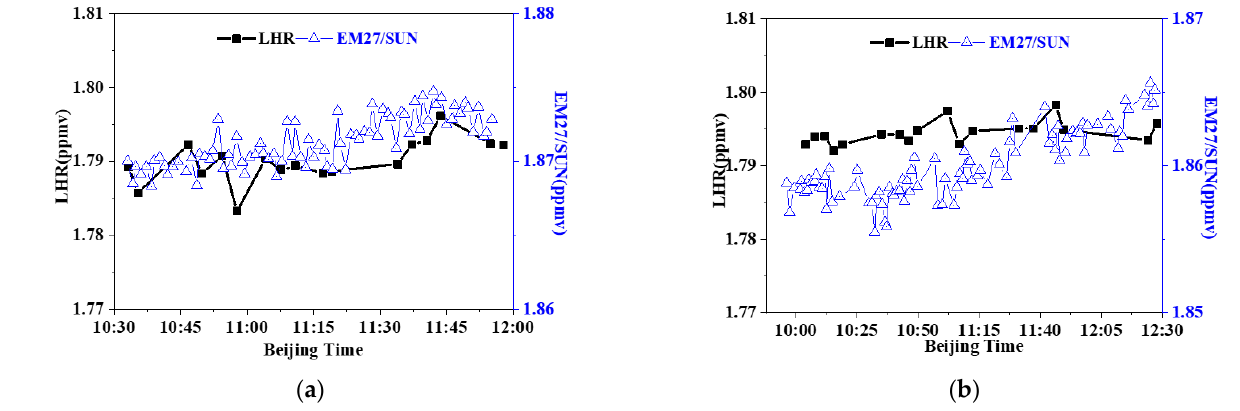
Figure 12. The methane column density of EM27/SUN and LHR on ( a ) 20 and ( b ) 21 July. The average values of methane measured by LHR were 1.79 ppmv on 20th and 1.794 ppmv on 21st, the EM27/SUN’s results were 1.871 ppmv and 1.86 ppmv, respectively. The relative errors of the averaged column densities are 4.33% and 3.53%. There may be three reasons that lead to differences between the results of LHR and EM27/SUN: (1) The spectral errors of LHR are larger than EM27/SUN’s and the a priori and the covariance matrix of water vapor and methane are different, these may induce to different results; (2) The abundance of HDO at Dunhuang may be different with HITRAN database; (3) In the target spectral range, there are 0.0786 cm − 1 intervals between the line of HDO (2831.8413 cm − 1 ) and CH 4 (2831.9199 cm − 1 ), the absorption of HDO and CH 4 is too close with each other which influences the retrieval results; (4) The last reason is the retrieval band of water vapor and methane by EM27/SUN is 8353.4–8463.1 cm − 1 and 5897-6145 cm − 1 respectively, but by the LHR just using single or several absorption peaks which is very sensitive to the concentration variation.